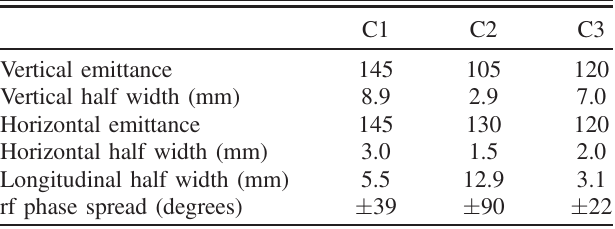
TABLE II. Beam parameters at the first acceleration gap as calculated using TOSCA, based on a 3 mm × 30 mrad beam with 0.5% momentum spread. The emittances are percentages of the incoming beam.